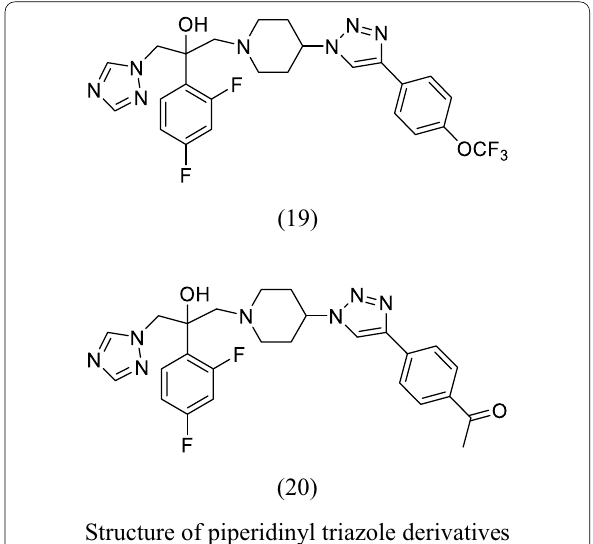
Fig. 25 Structure of piperidinyl triazole derivatives